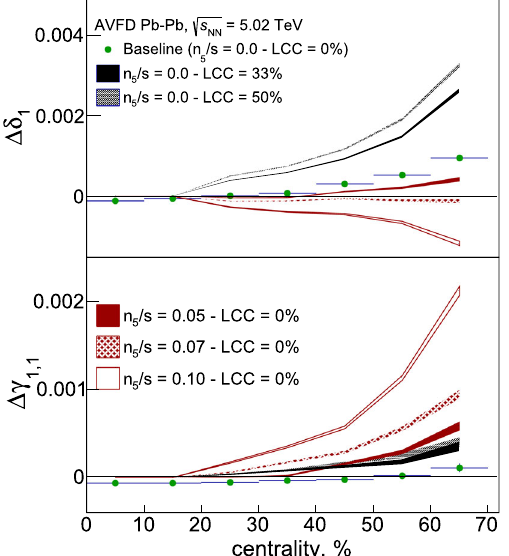
Fig. 3 The centrality dependence of (cid:9)δ 1 (upper panel) and (cid:9)γ 1 , 1 (lower panel), the charge dependent difference of δ 1 and γ 1 , 1 between √ s NN = 5 . 02TeV. opposite-andsame-signpairs,inPb–Pbcollisionsat The results from the analysis of the baseline sample are represented by the green markers. The various bands show the AVFD expectations for (cid:9)γ / s (red bands) and percentage (cid:9)δ 1 and 1 , 1 for various values of n 5 of LCC (blue